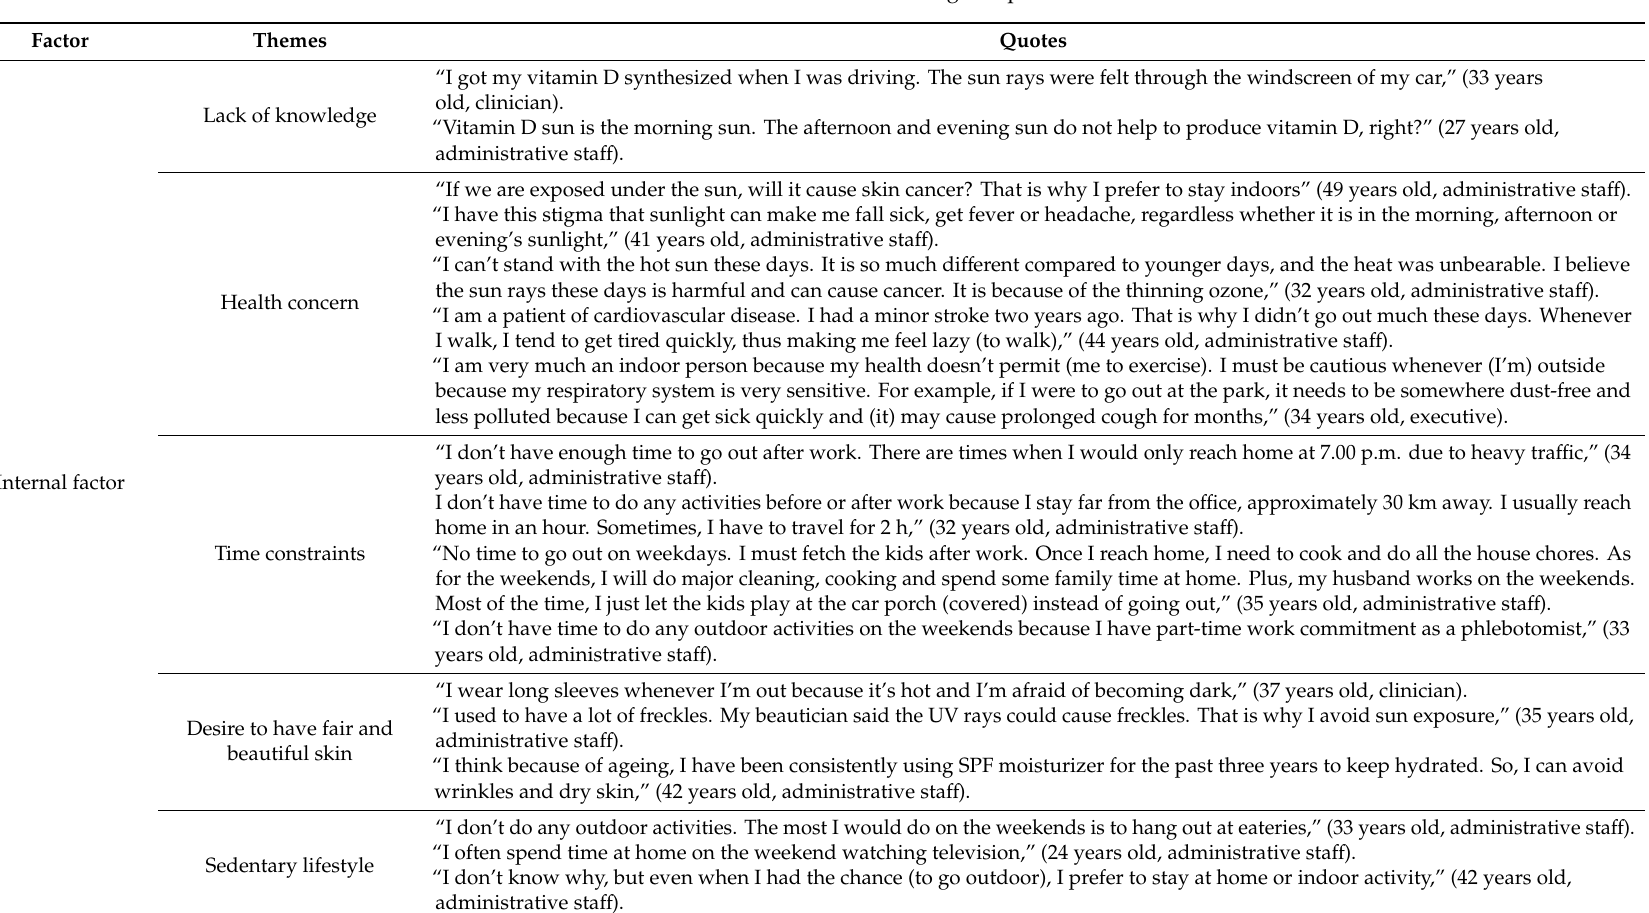
Table 3. Themes for barriers towards sunlight